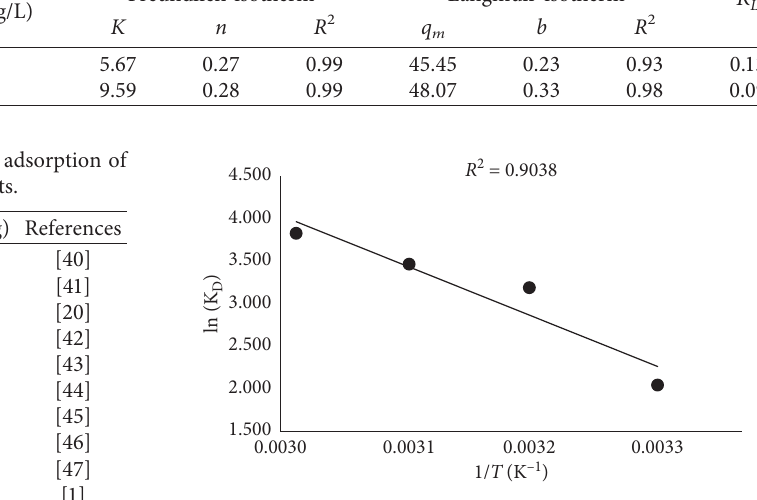
Figure 9: Thermodynamic parameters for the sorption of meth- ylene blue onto Ginkgo biloba leaves. Table 3: Thermodynamic parameters for the sorption of MB onto